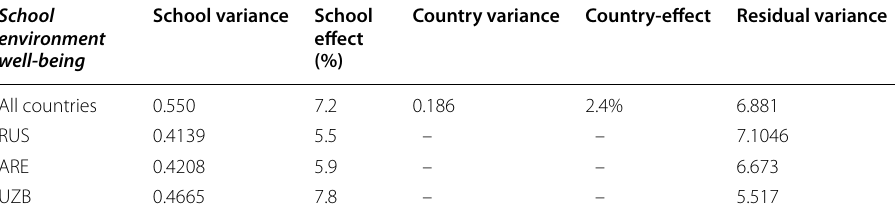
Table 3 PVRE by country and by school in teachers’ individual well-being Individual well-being All countries ARE UZB